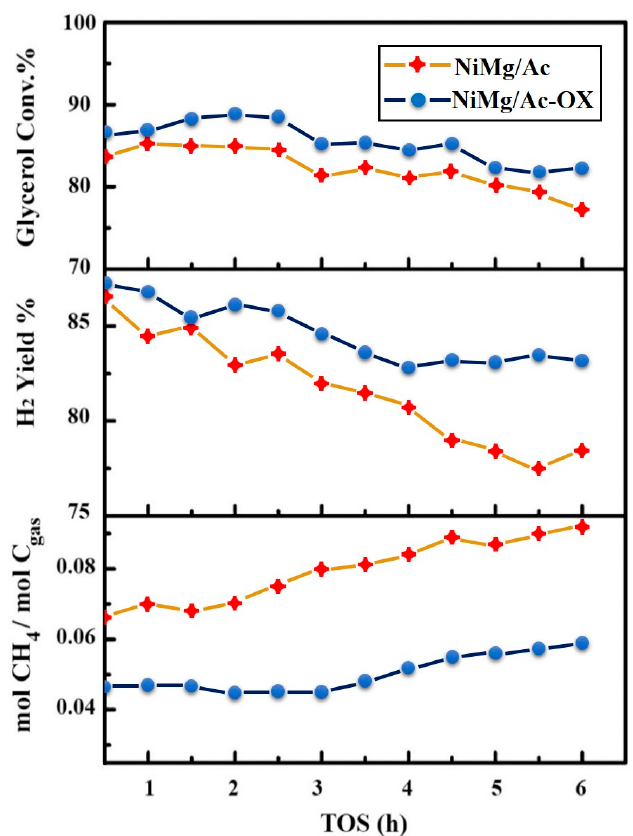
Figure 5. Over NiMg / AC and NiMg / AC-OX catalysts at 650 ◦ C [28] (redrawn with copyright Figure 5. Over NiMg/AC and NiMg/AC-OX catalysts at 650 °C [28] (redrawn with copyright permission).